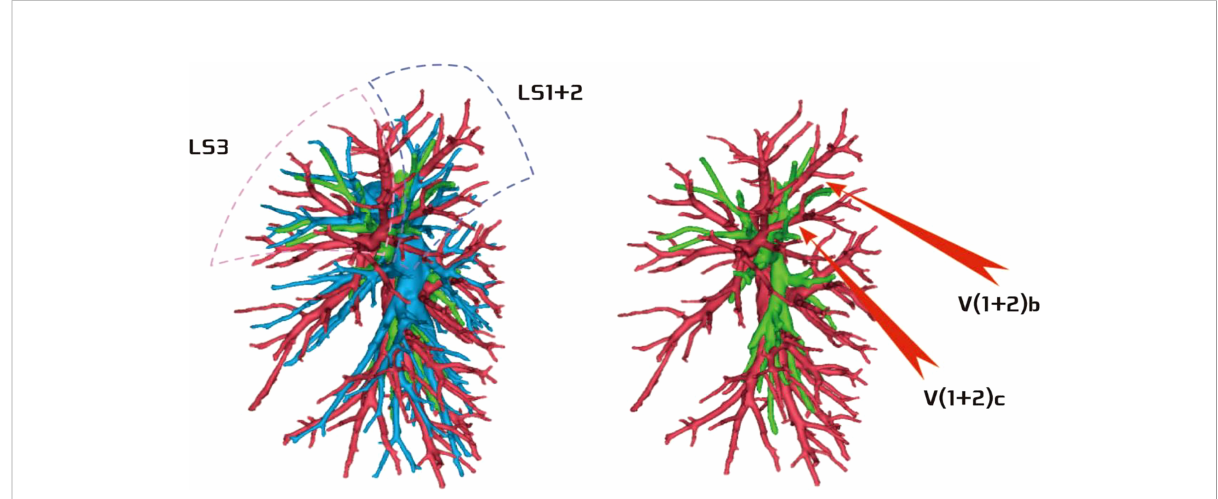
FIGURE 12 No central vein type: V(1 + 2)b and V(1 + 2)c walking above and below B3, respectively.